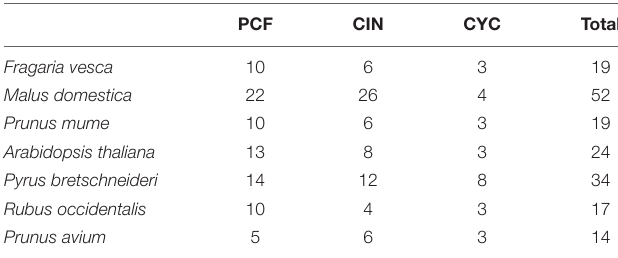
TABLE 1 | Number of genes in each subfamily of 7